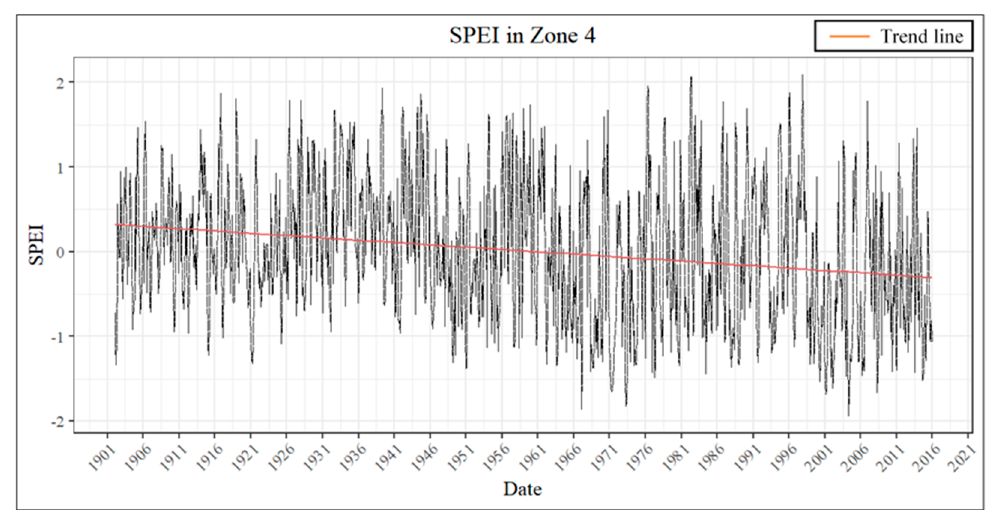
Appl. Sci. 2019 , 9 , x FOR PEER REVIEW Figure 13. Three-month SPEI from 1902–2015 for zone 4. Figure 13. Three-month SPEI from 1902–2015 for zone 4. Figure 13. Three-month SPEI from 1902–2015 for zone 4.